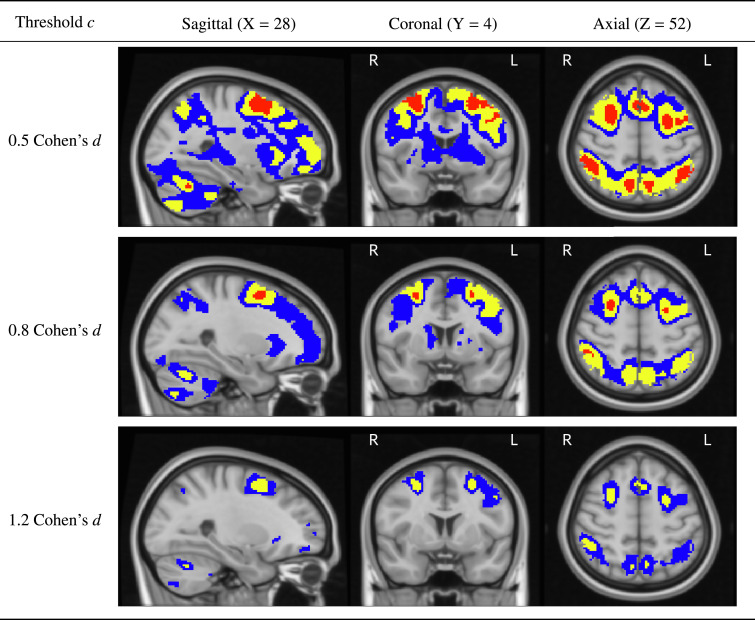
Slices views of the Cohen’s d Confidence Sets obtained from applying Algorithm 2 to the HCP working memory task data, using three Cohen’s d effect size thresholds, c=0.5,0.8 and 1.2. Comparing with Fig. 12, the upper and lower CSs presented here are almost identical to the corresponding CSs obtained with Algorithm 3.